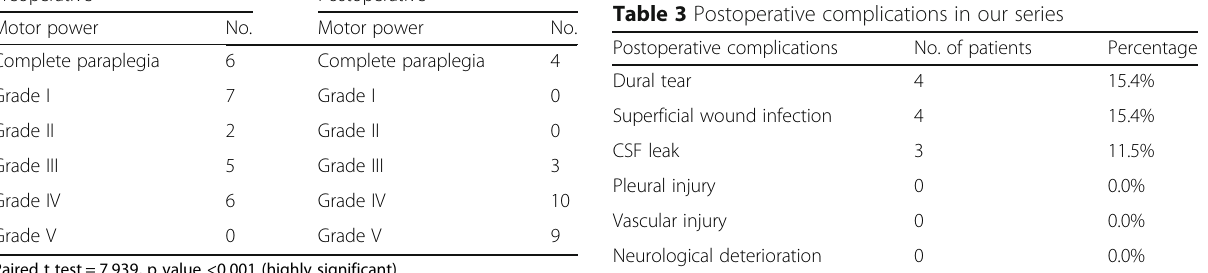
Table 2 Preoperative and postoperative muscle power state Preoperative